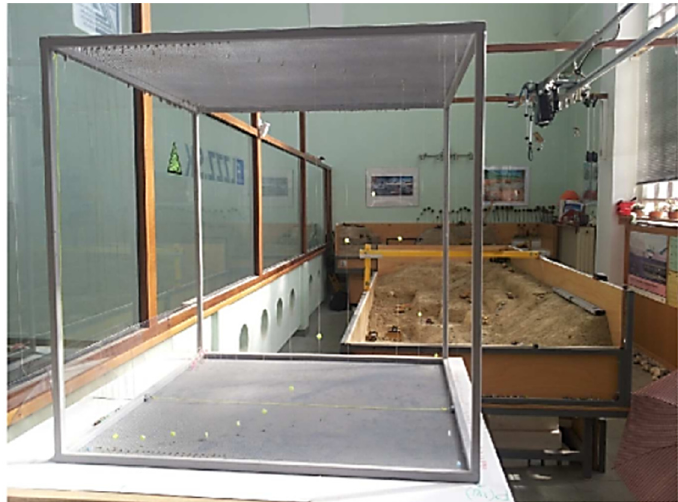
Figure 1. Laboratory of Earth Resource Extraction, Cube [37].